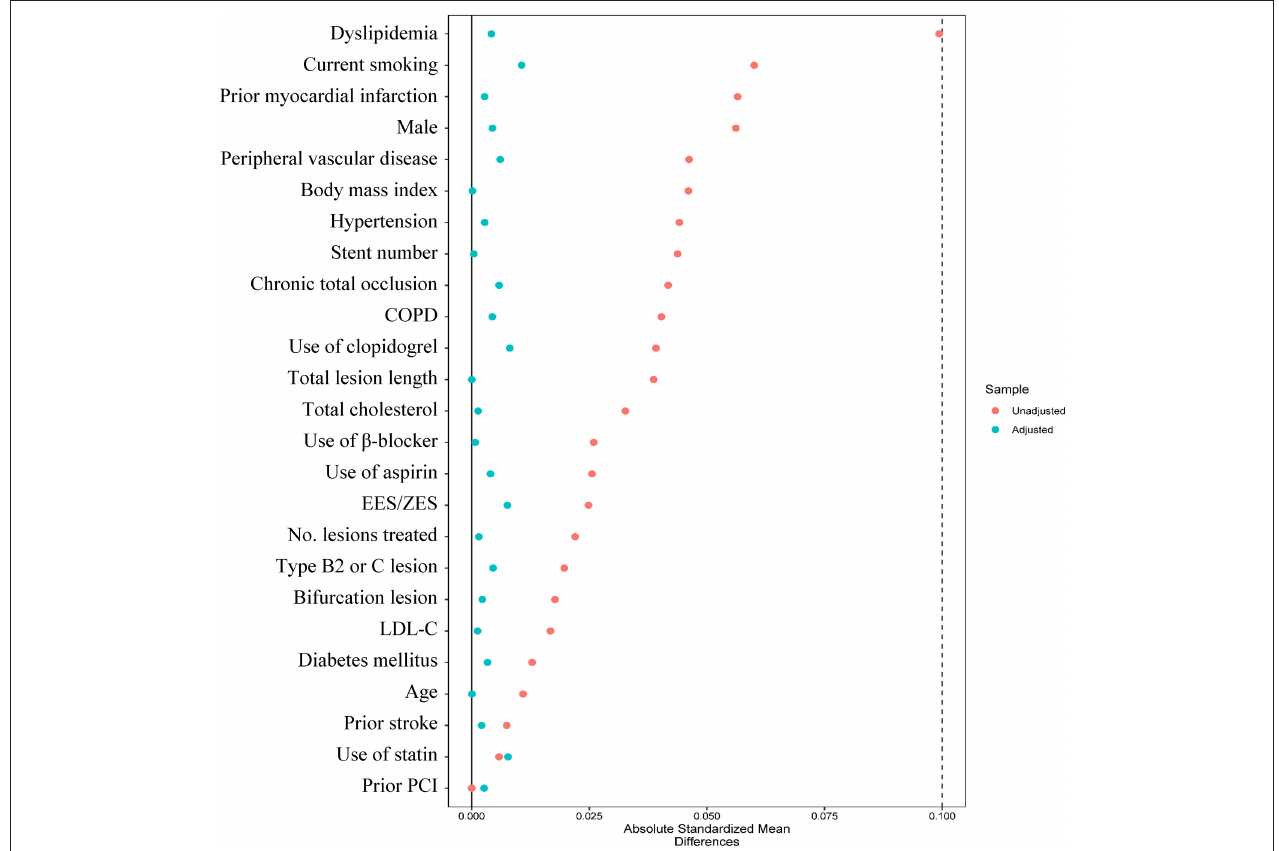
FIGURE 4 | Absolute standard difference before and after inverse probability of treatment weighting analysis between DAPT > 1-year and DAPT ≤ 1-year groups. COPD, chronic obstructive pulmonary disease; EES, everolimus-eluting stent; LDL-C, low-density lipoprotein cholesterol; PCI, percutaneous coronary intervention; ZES, zotarolimus-eluting